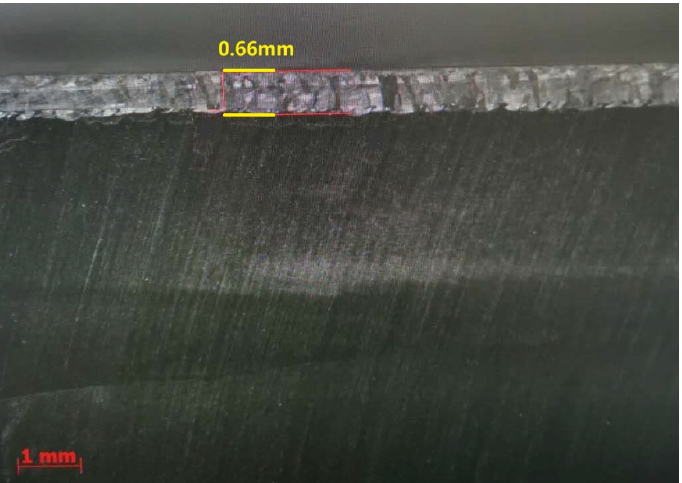
Figure 10. Macroscopic metallographic analysis of the welded plate with upgraded parameters.